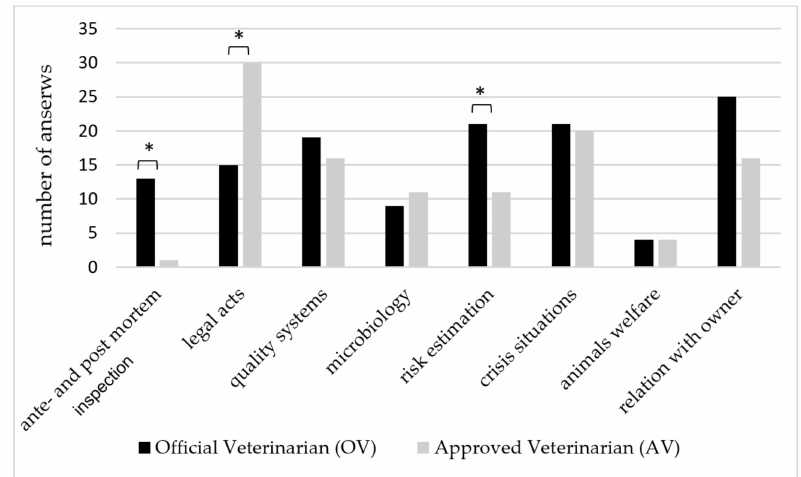
Figure 1. The topics that were declared as the most di ffi cult for Veterinary Food Inspectors (VFIs). * Asterisks indicate statistically significant di ff erences ( p < 0.05) between OVs and AVs.